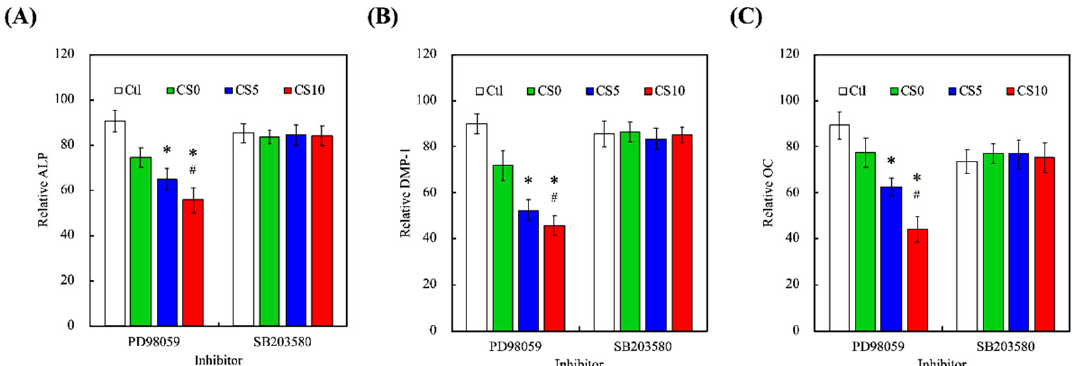
Figure 10. Expressions of ( A ) ALP, ( B ) DMP-1 and ( C ) OC of hDPSCs-laden CS/GelMa scaffolds after treatment of PD98059 and SB203580 inhibitors against for ERK1/2 and p38, respectively. The values of the untreated groups were used as the 100% reference level. For different time-points. * = significant difference as compared to CS0 and # = significant difference as compared to CS5 ( p < 0.05). Data are presented as mean ± SEM, n = 6 for each group.